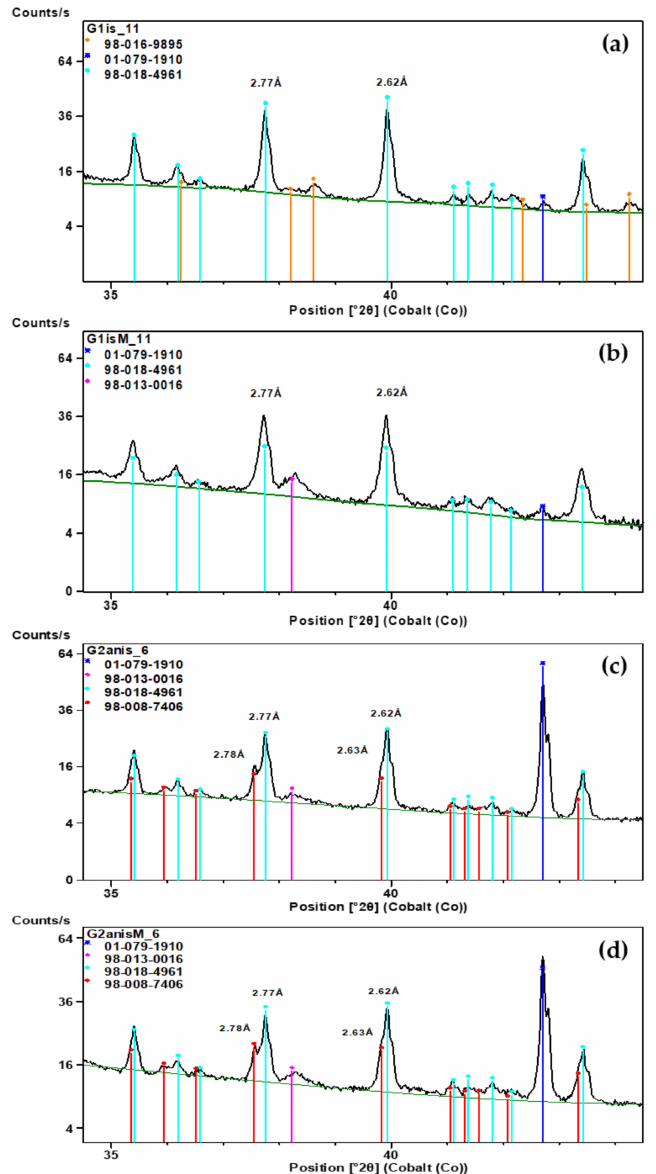
Figure 14. XRD patterns in the 2 θ region 34.5–44.5 ◦ . Legend: 98-018 4961 = SrFe 12 O 19 –98-008-7406 = Ba 0.98 Fe 11.93 O 18.84 –01-079-1910 = quartz–98-013-0016 = vaterite–98-016-9895 = aragonite; ( a ) G1is_11, FWHM of is-SrFe 12 O 19 main peak = 0.11 ◦ 2 θ ; ( b ) G1isM_11, FWHM of SrFe 12 O 19 main peak = 0.12 ◦ 2 θ ; ( c ) G2anis_6 FWHM of SrFe 12 O 19 main peak = 0.09 ◦ 2 θ –FWHM of Ba 0.98 Fe 11.93 O 18.84 main peak = 0.10 ◦ 2 θ ; ( d ) G2anisM_6 FWHM of SrFe 12 O 19 main peak = 0.10 ◦ 2 θ –FWHM of Ba 0.98 Fe 11.93 O 18.84 main peak = 0.11 ◦ 2 θ